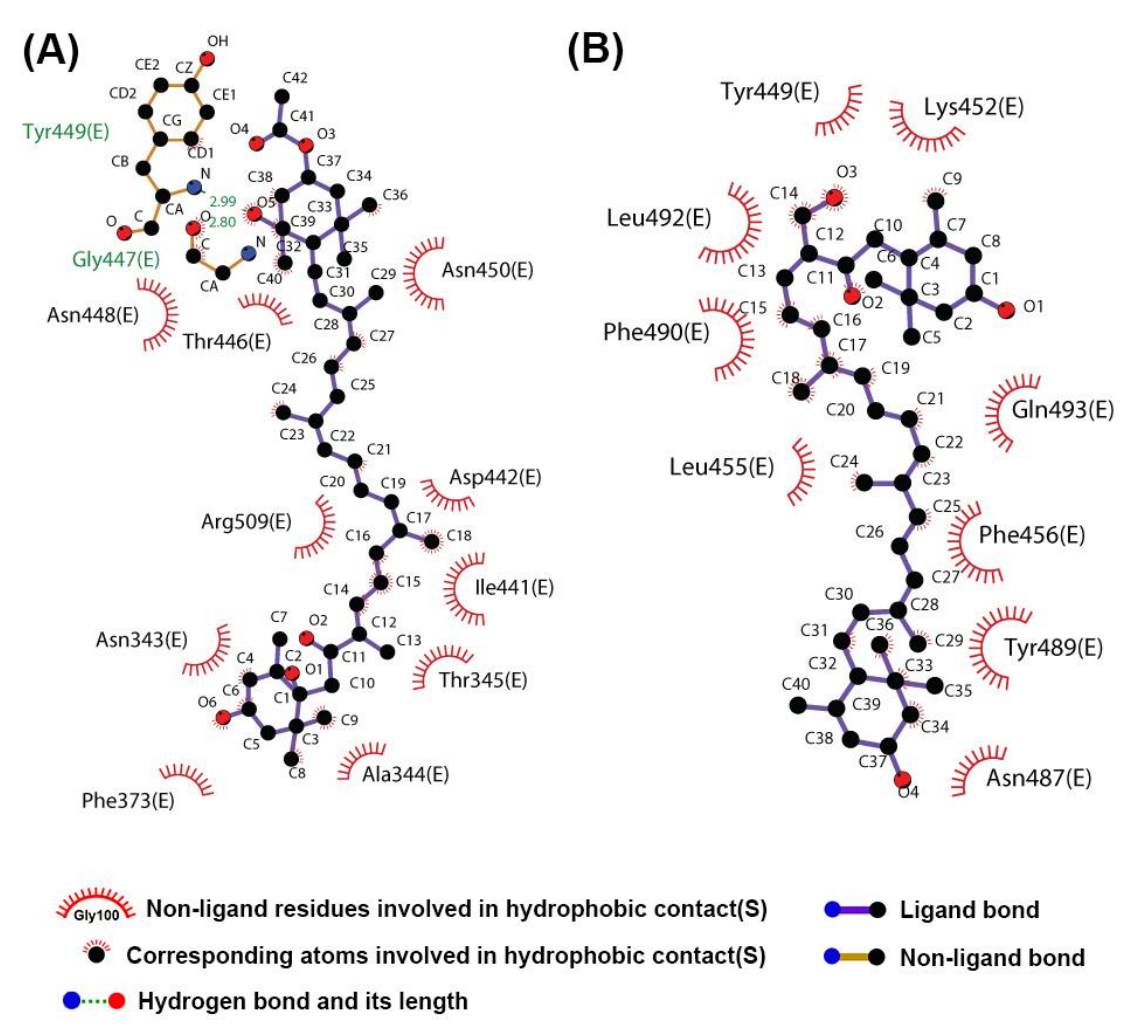
Figure 2. The potential protein–ligand interactions of SARS-CoV-2 chimeric receptor-binding domain (RBD) and ligands. The best-docked poses for ( A ) fucoxanthin and ( B ) siphonaxanthin in RBD were made with LigPlot. Table 1. Interaction and binding energy of ligands with SARS-CoV-2 chimeric receptor-binding do- main (RBD) in silico.